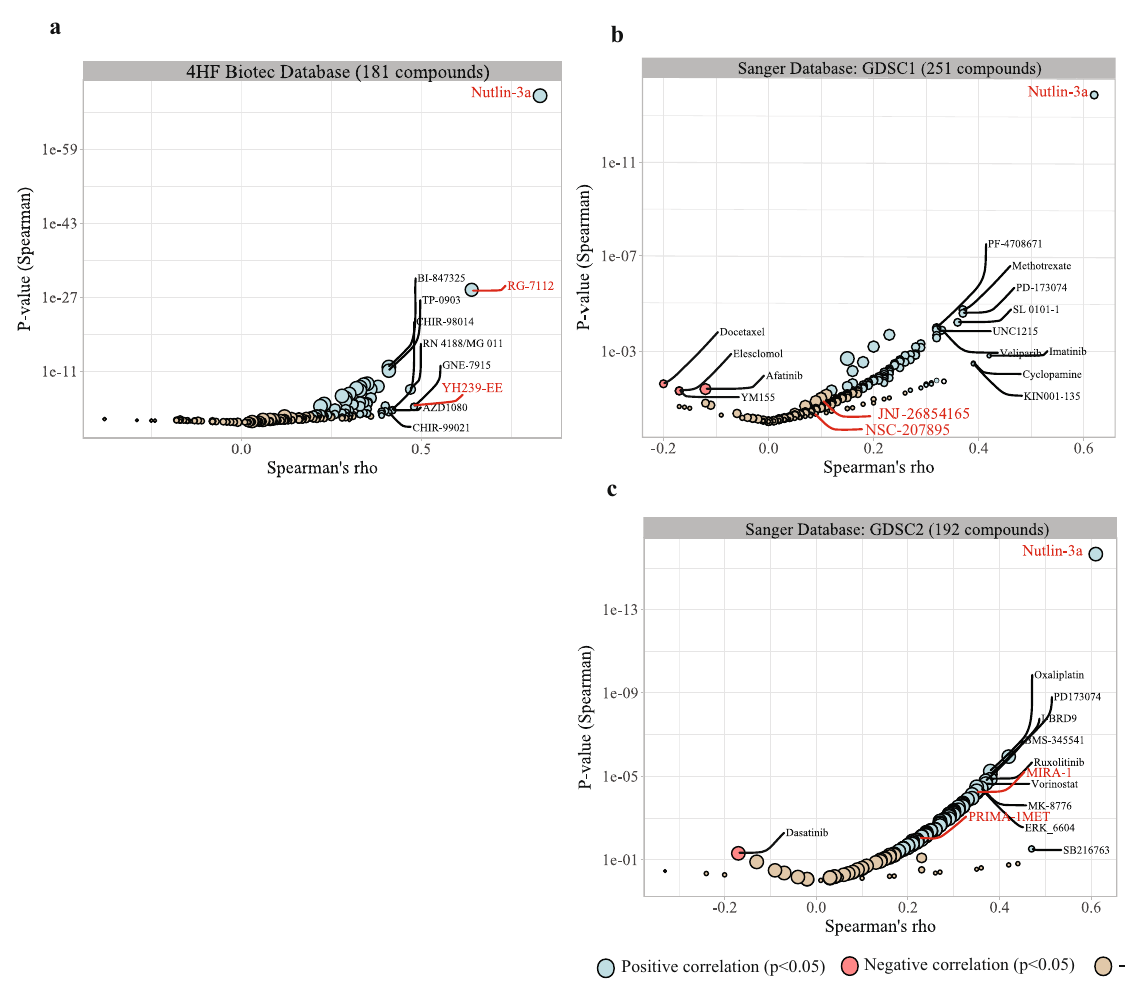
Fig. 2 COMPARE analysis of MI-773 mechanism of action. Volcano plot showing the anti-cancer drugs correlated with MI-773 Abs IC 50 (COMPARE analysis). x -axis: Rho values obtained (Spearman), y -axis: p -values. Blue: anti-cancer drugs with a positive correlation ( p -values < 0.05), red: negative correlation ( p -values < 0.05) (light brown: not signi fi cant). a 4HF Biotec database, b and c Sanger GDSC1 and GDSC2 databases. The size of the circles is proportional to the number of data points